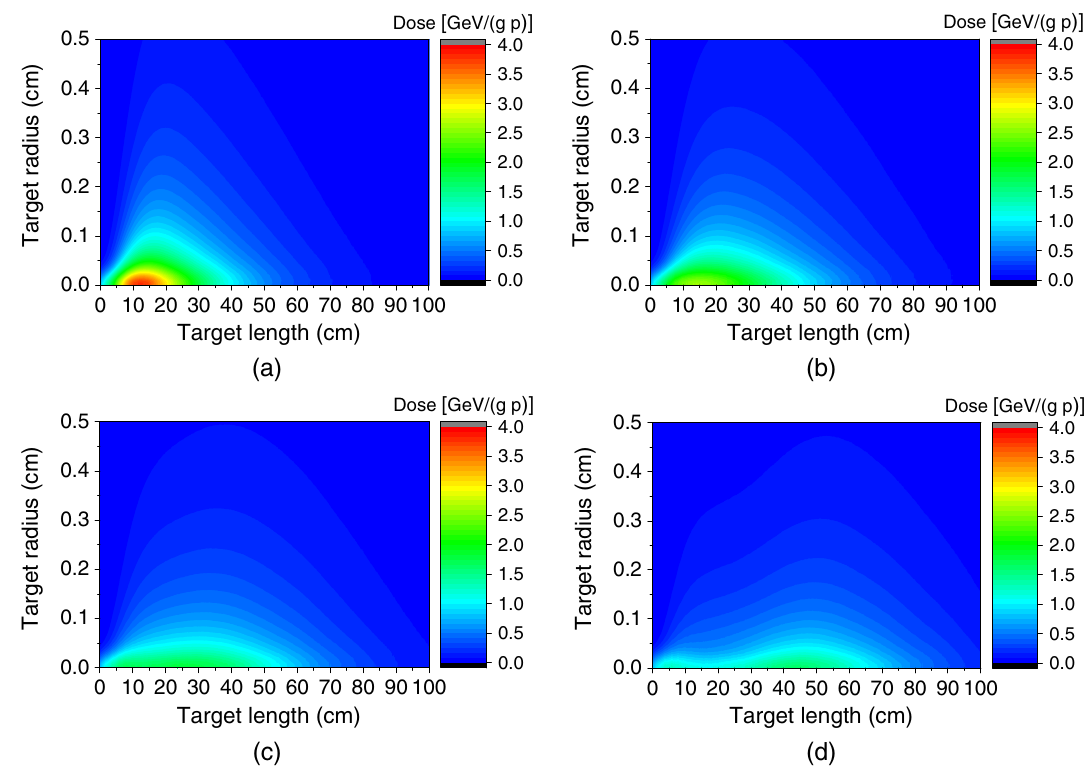
FIG. 2. Two-dimensional distributions of the dose in units of GeV = ð g p Þ in the r - z plane calculated by FLUKA for bunches delivered at different times: (a) using a nominal solid-copper density of 8 . 94 g = cm 3 at t ¼ 0 μ s, when bunch 1 started impacting the target, (b) using the density distribution provided by Autodyn at t ¼ 2 μ s, just before bunch 37, (c) using the density distribution provided by Autodyn at t ¼ 4 μ s, just before bunch 73, and (d) using the density distribution provided by Autodyn at t ¼ 6 μ s, just before bunch 109.